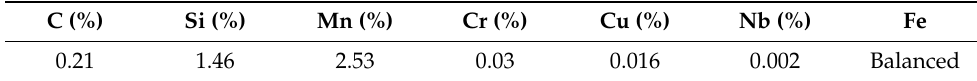
Figure 1. ( a ) Geometry of the hot tensile testing specimen and ( b ) the initial microstructure. Table 1. Chemical composition of the DP1200HD